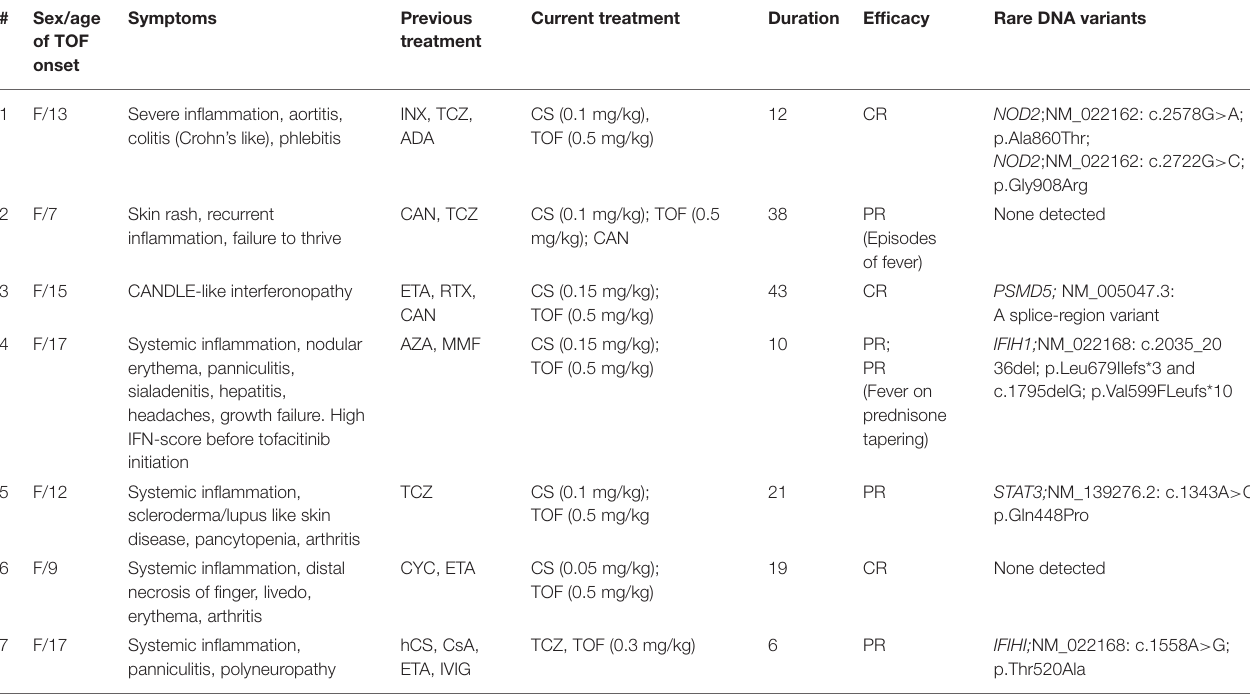
TABLE 3 | The clinical characteristics and genetic findings in patients with